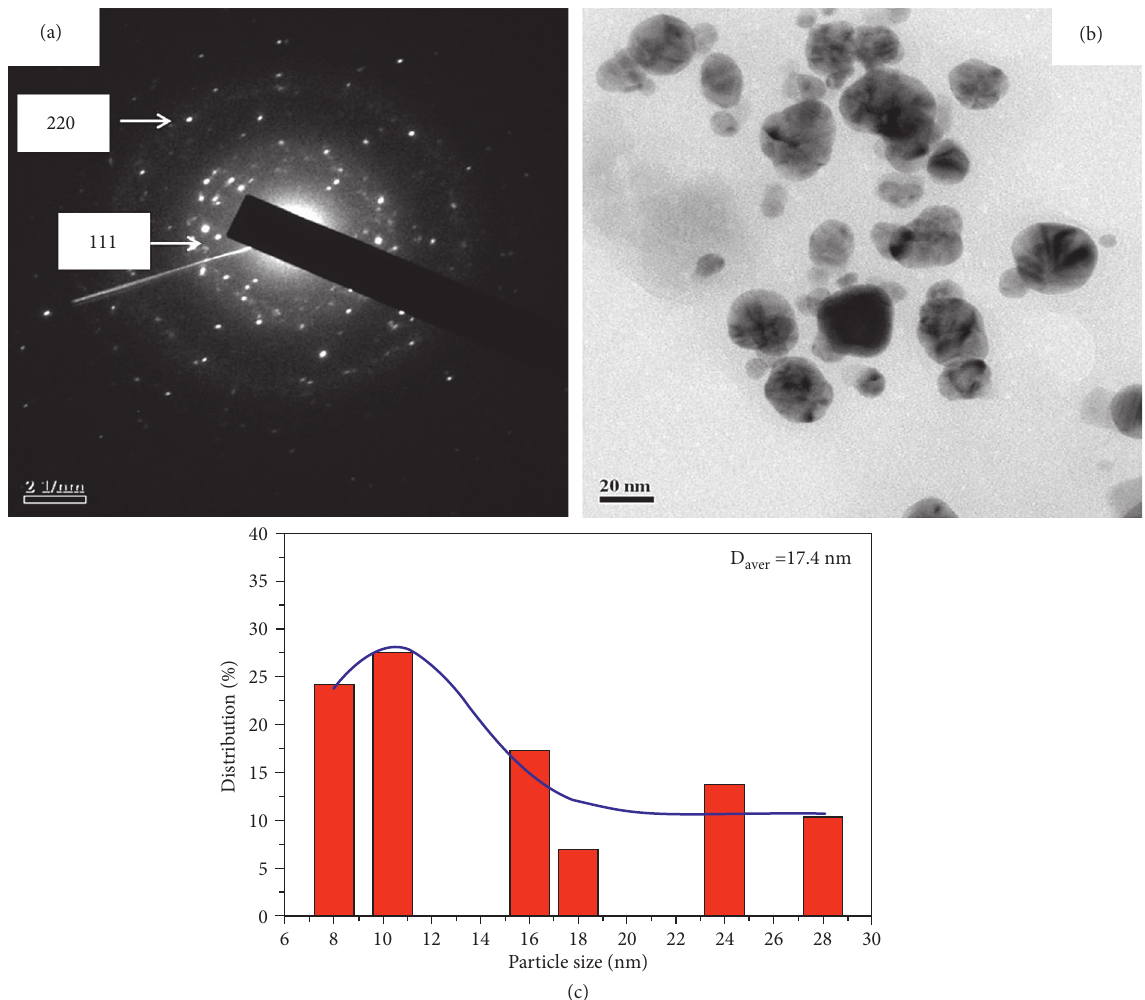
Figure 3: TEM micrograph of the synthesized Ag NPs. (a) SAED pattern of synthesized Ag NPs. (b) Analysis of the morphology of Ag NPs. (c) Histogram showing the size distribution of Ag NPs [85] (open access and reprinted under CC BY